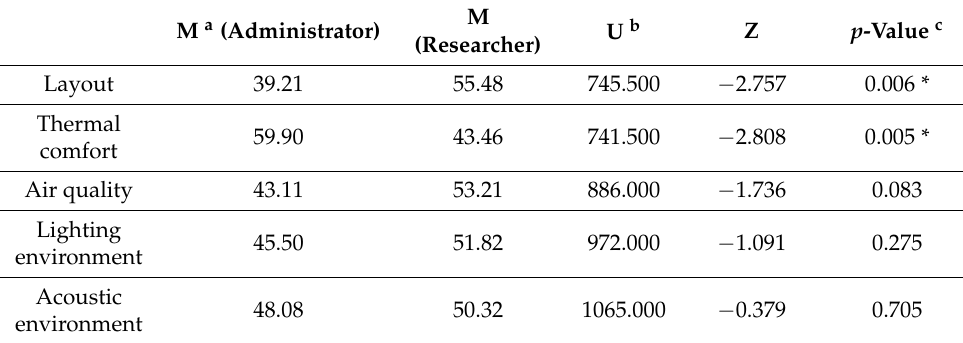
Table 6. Qualitative assessment of satisfaction in administrators and researchers, analyzed using the Mann–Whitney U